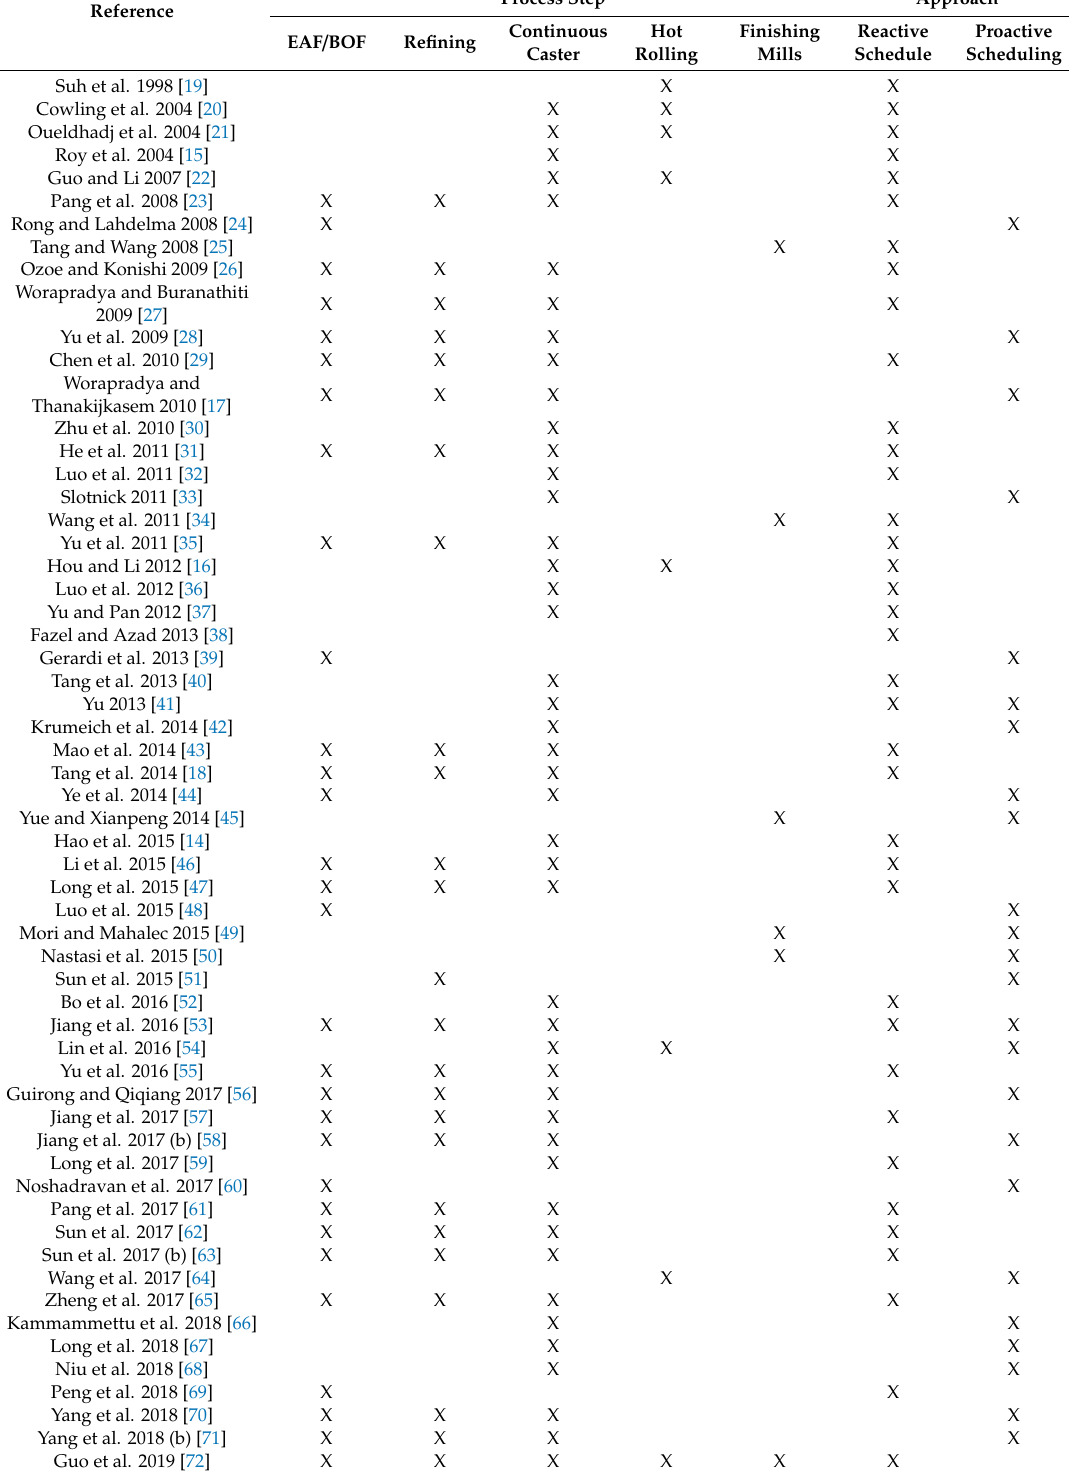
Table 1. Planning and scheduling models dealing with uncertainty in steel